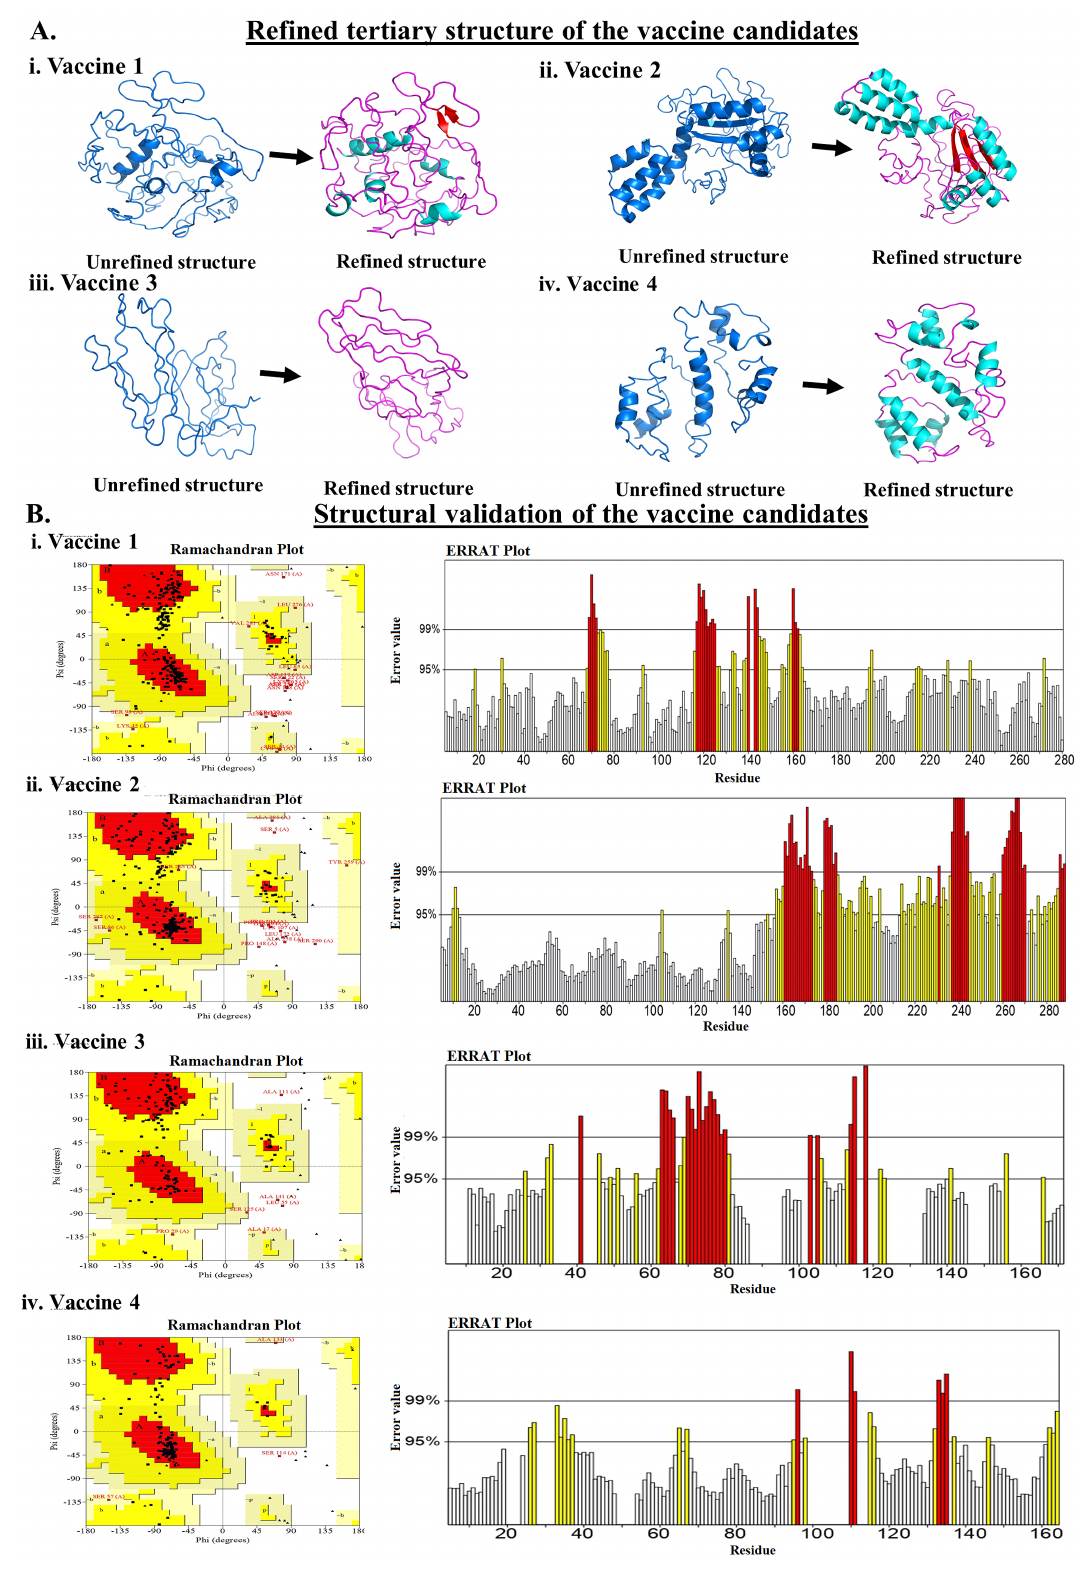
Figure 2. 3D structure of the vaccine candidates. ( A ). Refined tertiary structure of the ( i ). VACCINE l, ( ii ). VACCINE 2, ( iii ). VACCINE 3, and ( iv ). VACCINE 4. Blue and magenta colors represent unrefined and refined structures. ( B ). Structural validation of the 3D structures. Ramachandran plot and ERRAT value plots for ( i ). VACCINE l, ( ii ). VACCINE 2, ( iii ). VACCINE 3, and ( iv ). VACCINE